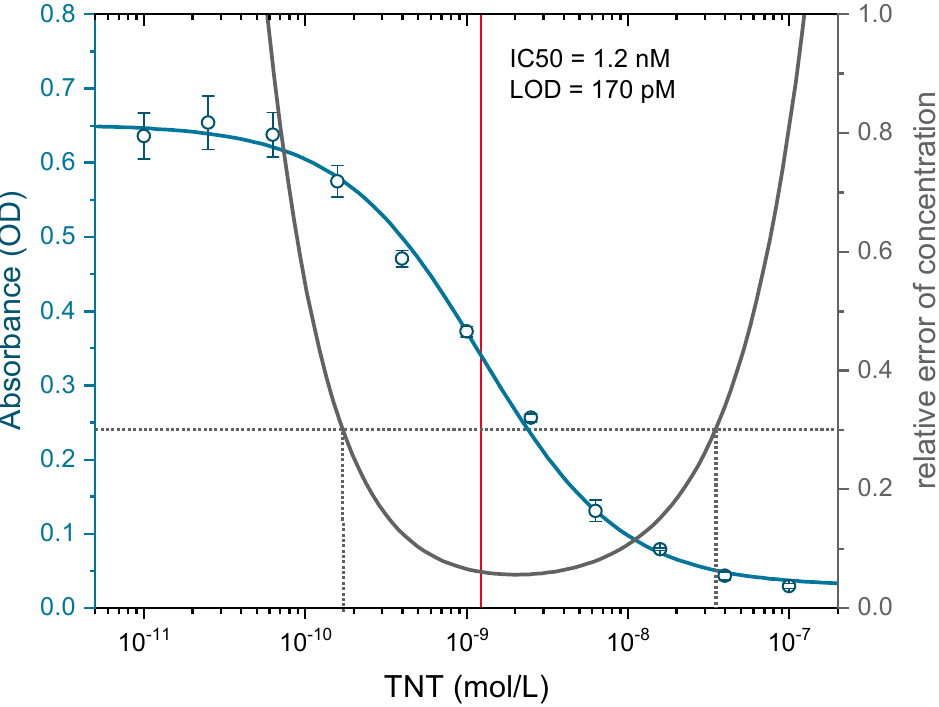
Figure 5. Calibration curve (blue) and precision profile (black) of an indirect enzyme-linked immunosorbent assay (ELISA) with the monoclonal antibody A1.1.1. The analyte TNT was determined in quadruplicates.